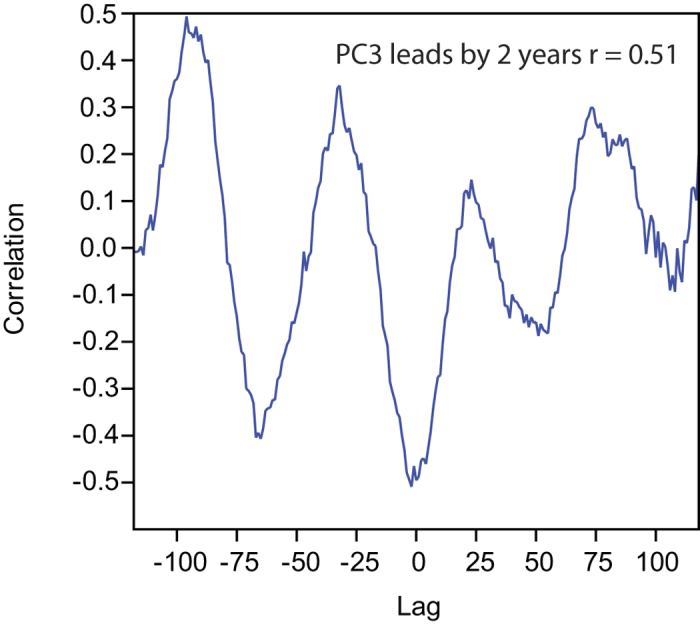
Cross-correlation between the annually-resolved coral growth rate record from the Yucatan Peninsula30 and Jamaican PC3 timeseries27 for the period 1773–2008.